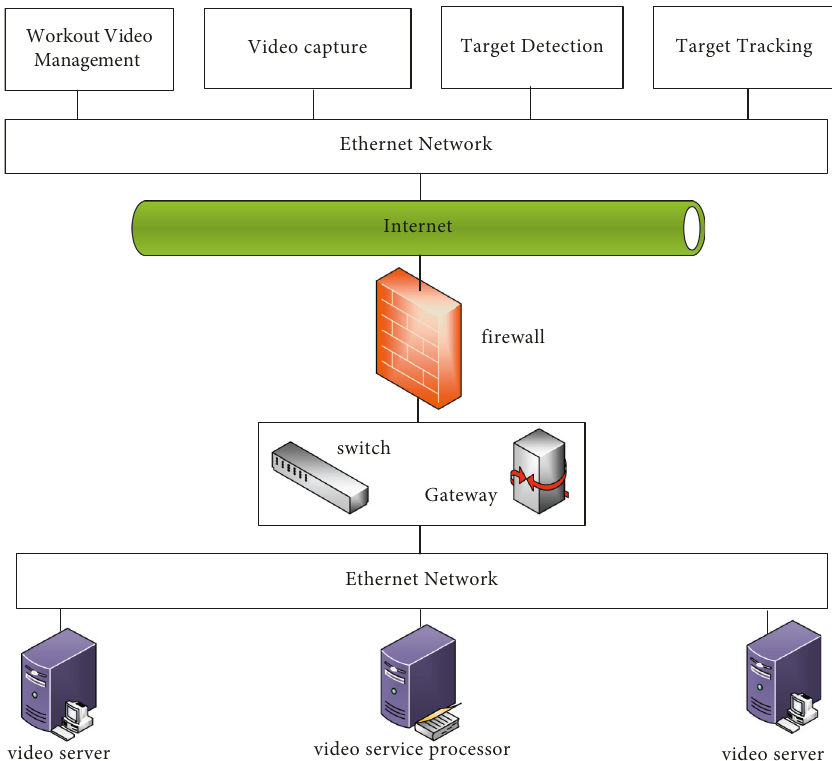
Figure 1: System information collection diagram.